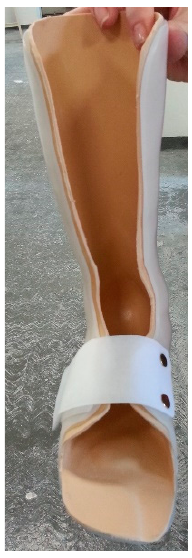
Figure 3. The design of DAFO3 (blocks plantarflexion, allows free dorsiflexion, and provides addi- tional medial/lateral stability).